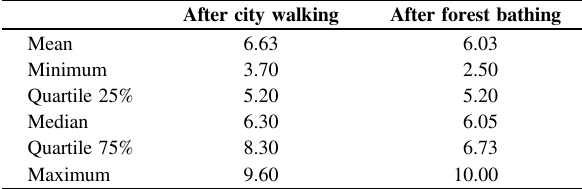
Fig. 1 Walking steps and physical activity during the forest bathing and urban area walking. “ Forest ” means after walking in the forest (forest bathing) and “ Urban ” means after walking in the urban area. Data are presented with mean + SD, p = 0.12, forest vs urban for walking steps; p = 0.58, forest vs urban for physical activity by paired t-test (n = 20). Table 2 Information of basic statistics of lactic acid (mg / dL) Table 3 Information of basic statistics of serotonin (ng / ml) After city walking Before